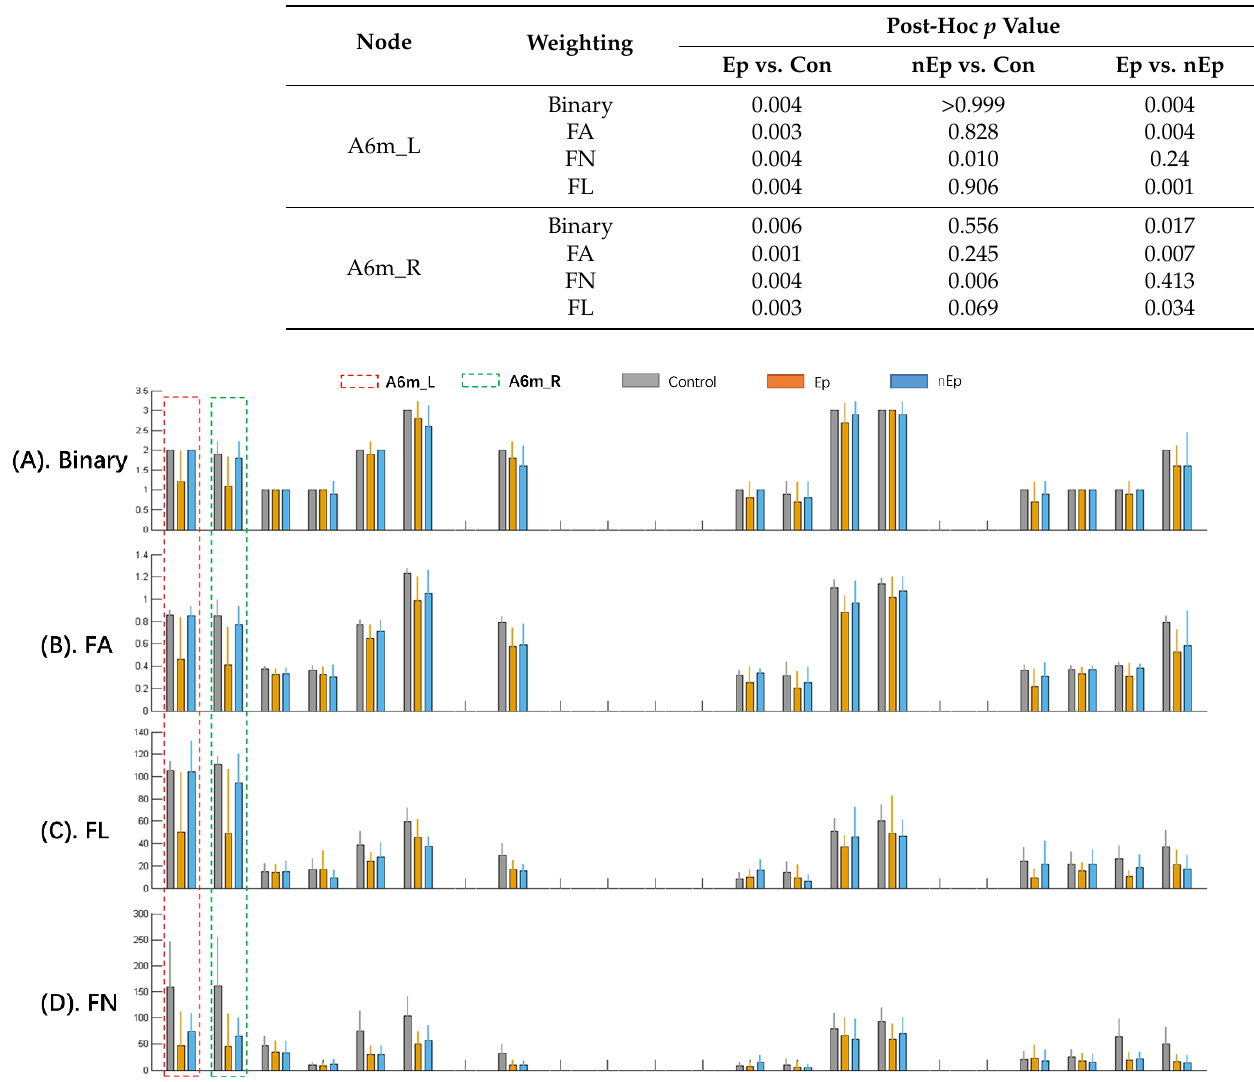
Table 7. Degree centrality difference of A6mL and A6mR.